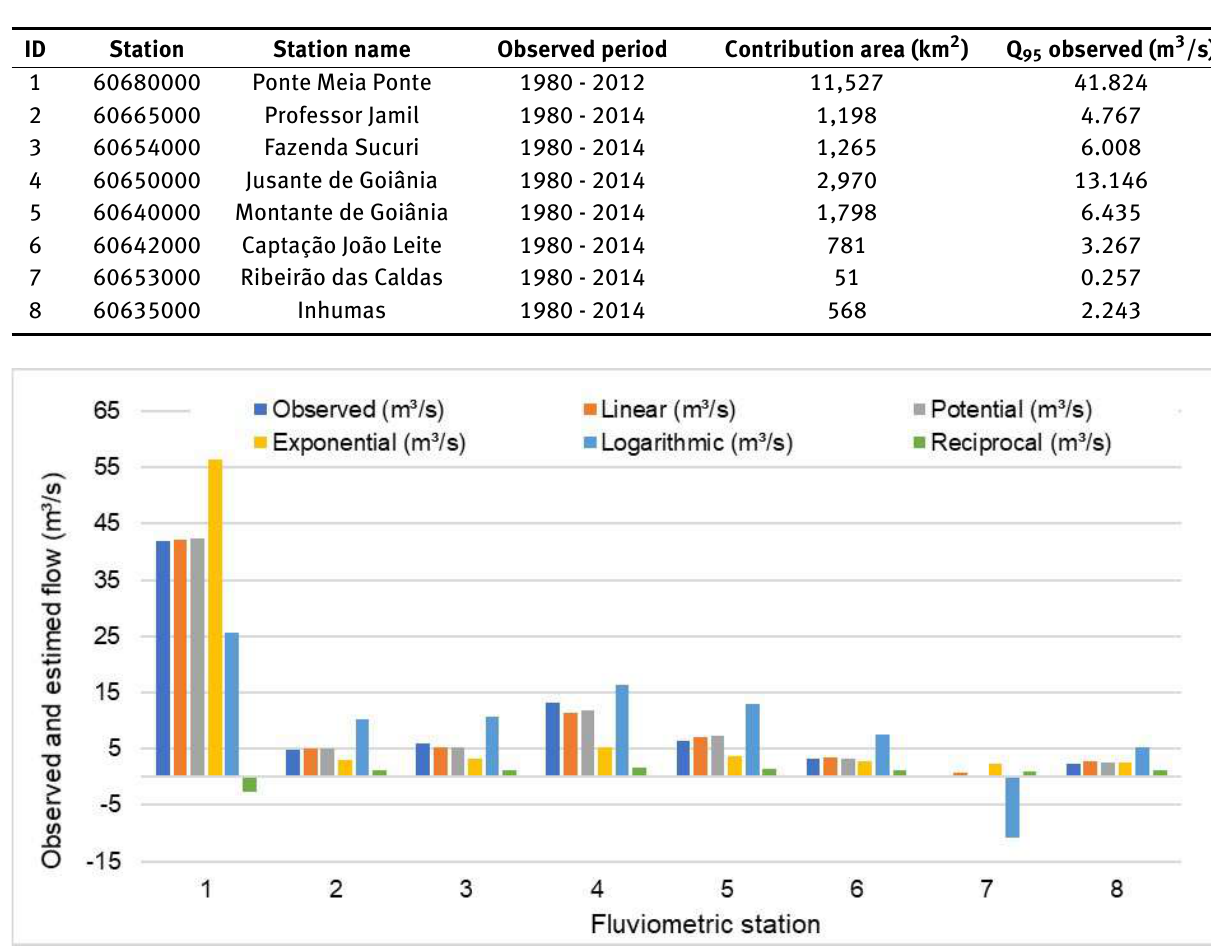
Table 1: Information on the fluviometric stations used.